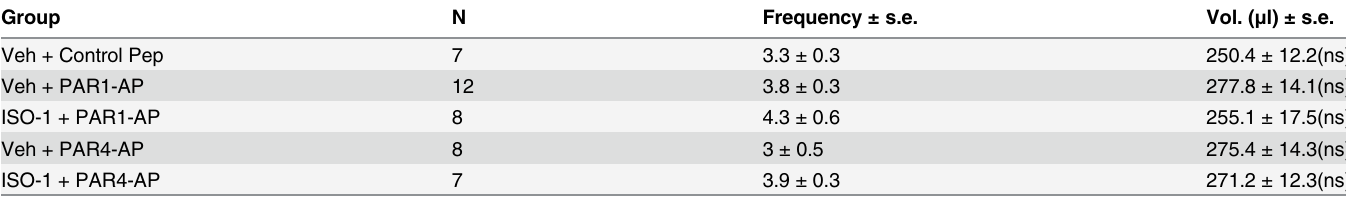
Table 2. Awake micturition parameters in PAR1-AP or PAR4-AP treated groups. Group N Frequency ±